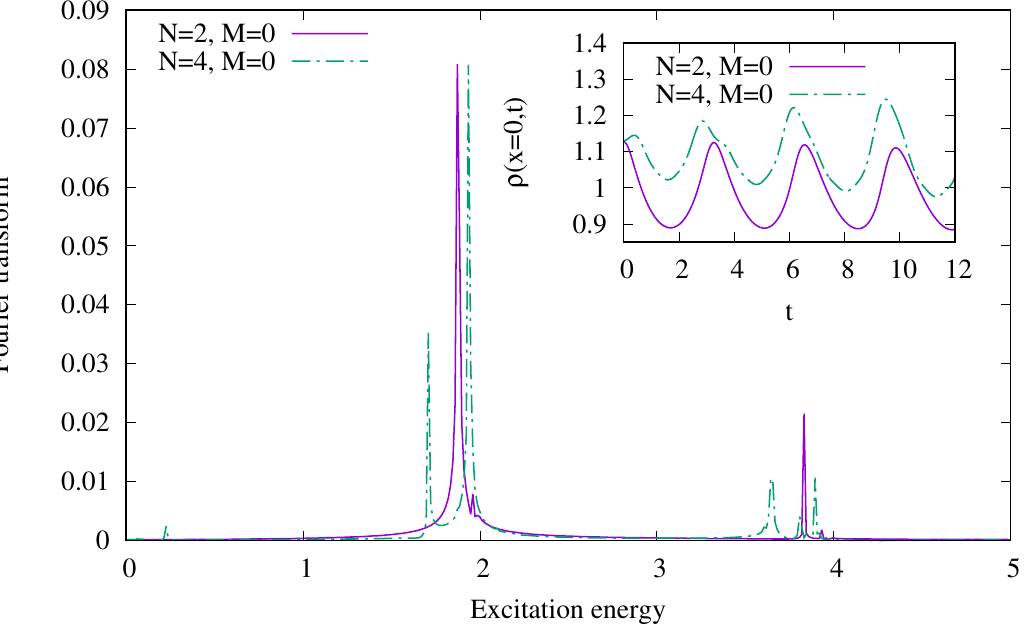
Figure 15. Frequency analysis of the time dependence of the central density after an interaction quench from g = 0 to g = 1. The average density has been subtracted. We consider the cases N = 2 (solid lines) and N = 4 (dot-dashed lines). In the inset we depict the first oscillations of the signal used to compute the Fourier analysis shown in the main panels. For the Fourier analysis we used a time interval, t = 500. All magnitudes in the figure are in harmonic oscillator